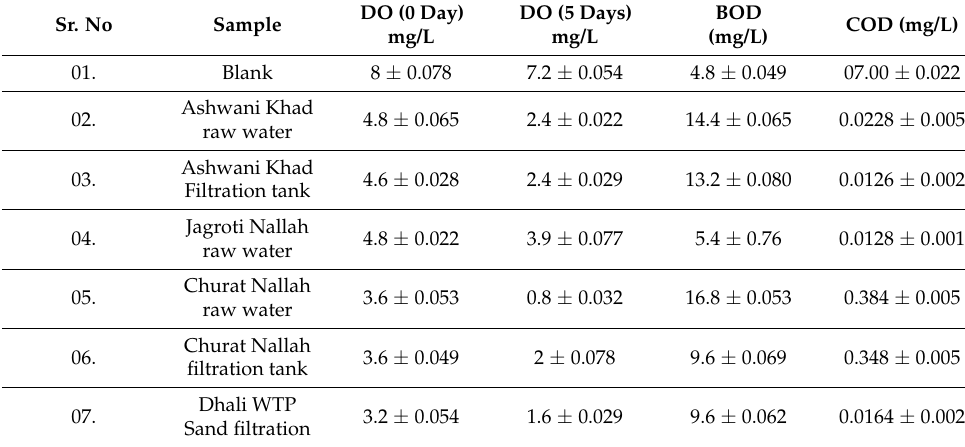
Table 6. BOD and COD for different water